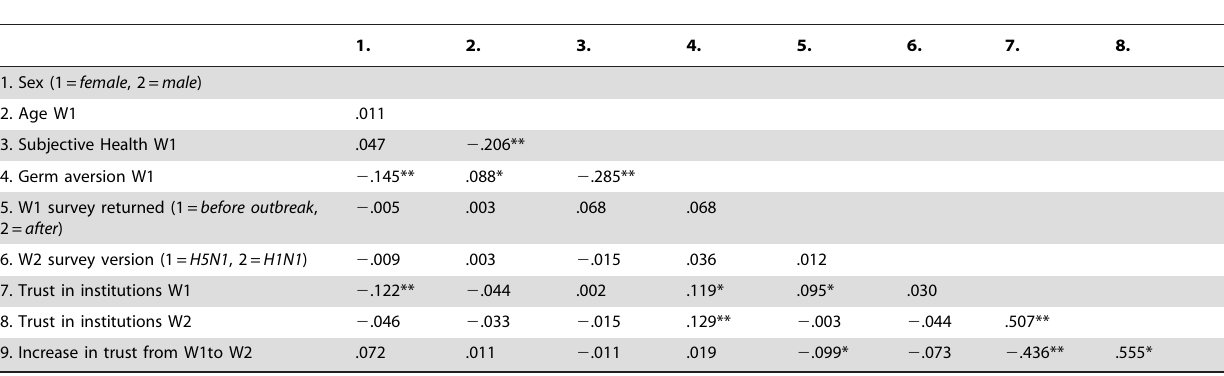
Table 2. Correlations Between Main Study Variables.